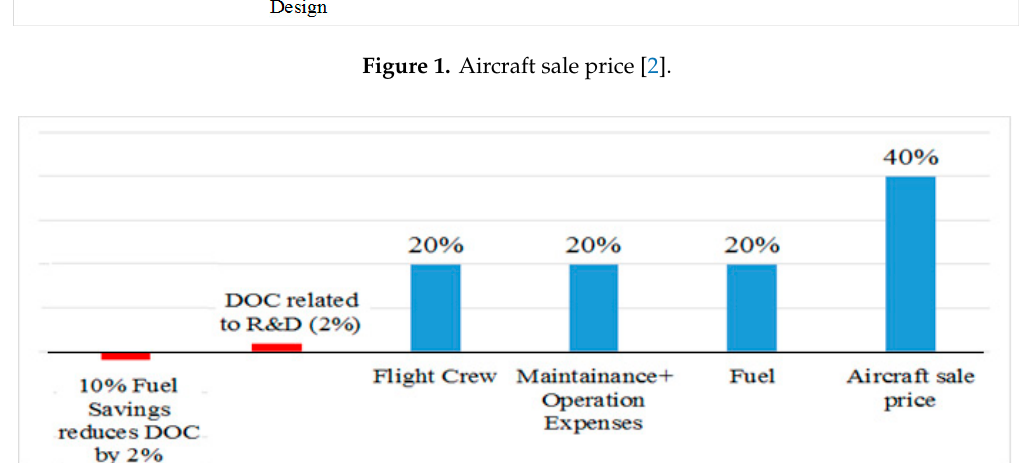
Figure 2. Direct operational cost (DOC) breakdown [2].